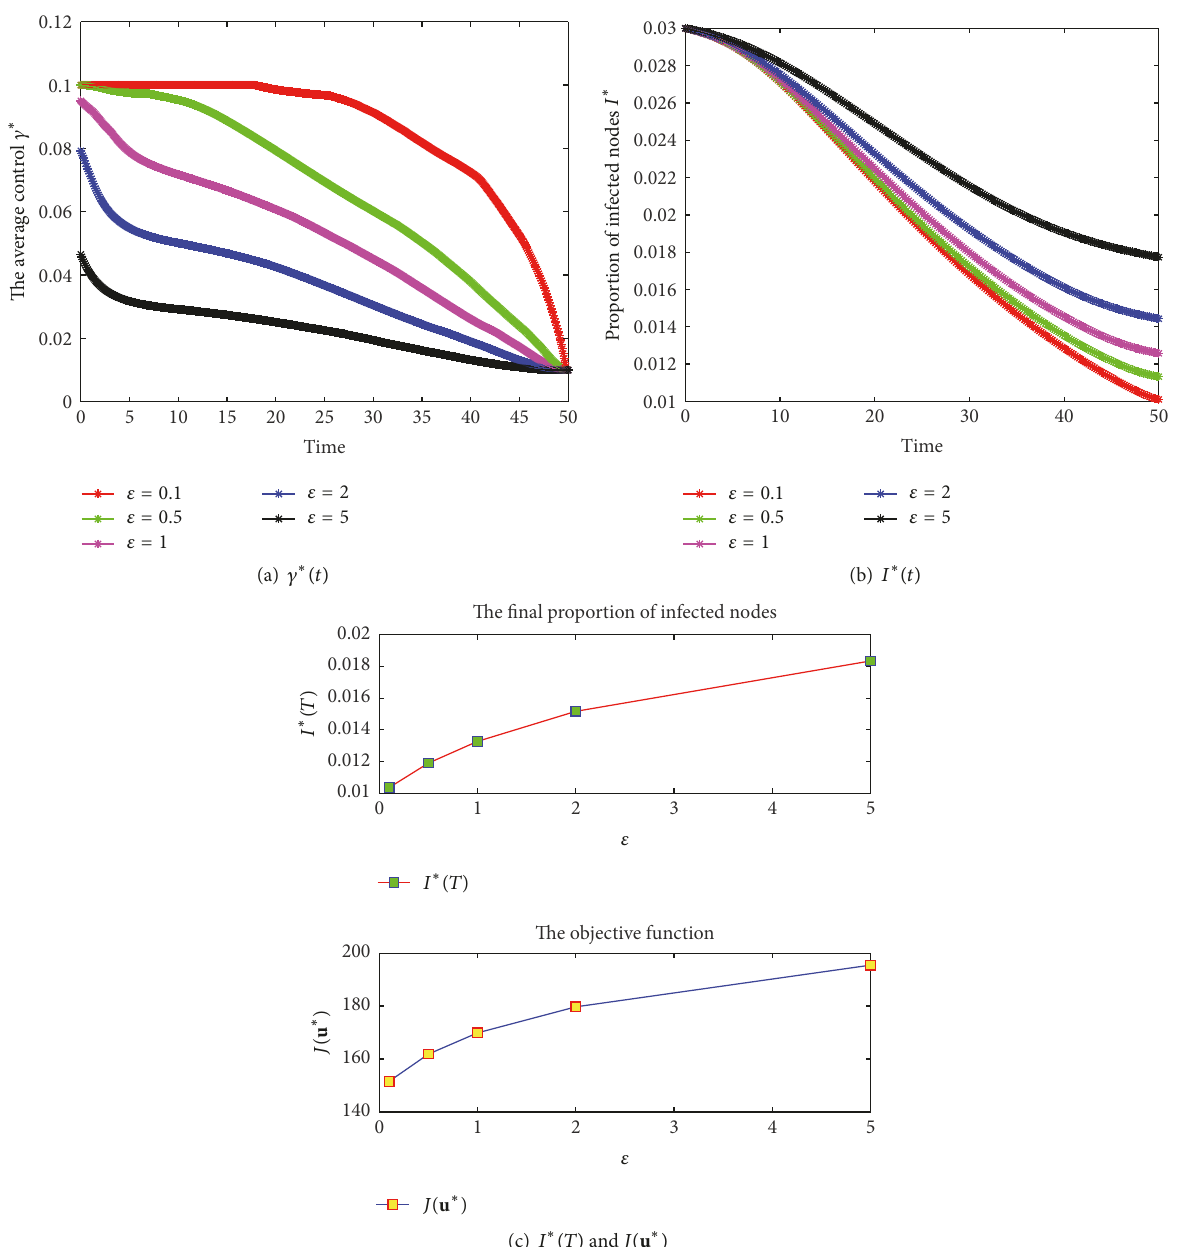
Figure 11: 𝛾 ∗ (𝑡) , 𝐼 ∗ (𝑡) , 𝐼 ∗ (𝑇) , and 𝐽( u ∗ ) for different 𝜀 with 𝑚 1 = 𝑚 2 = 5 for Example